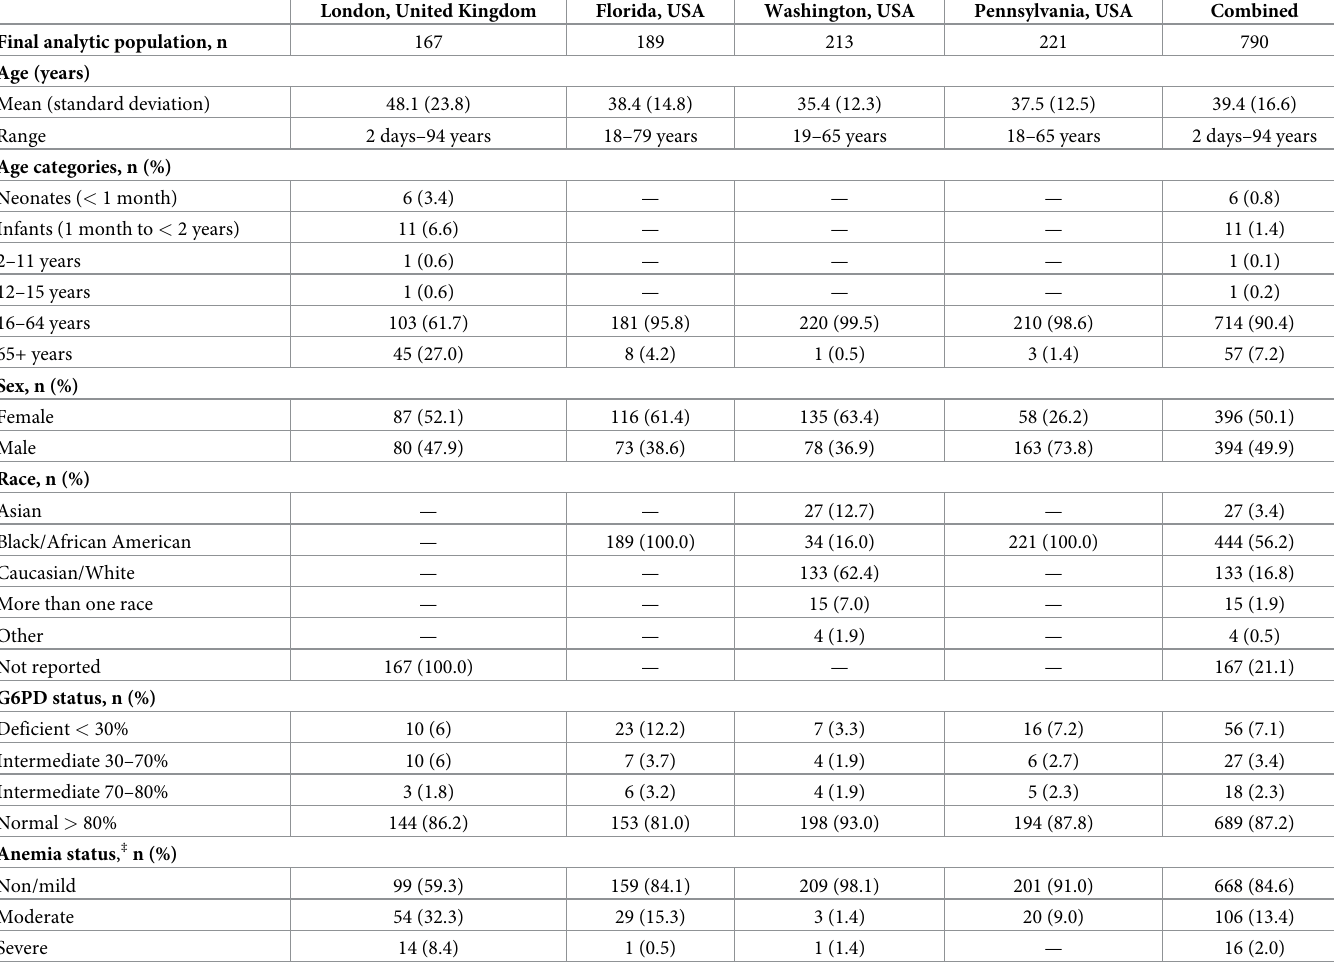
Table 2. Study donor demographics by age, sex, race, G6PD deficiency status, and anemia as determined by hemoglobin concentration. The demographics are pro- vided for the total number of study participants included in the